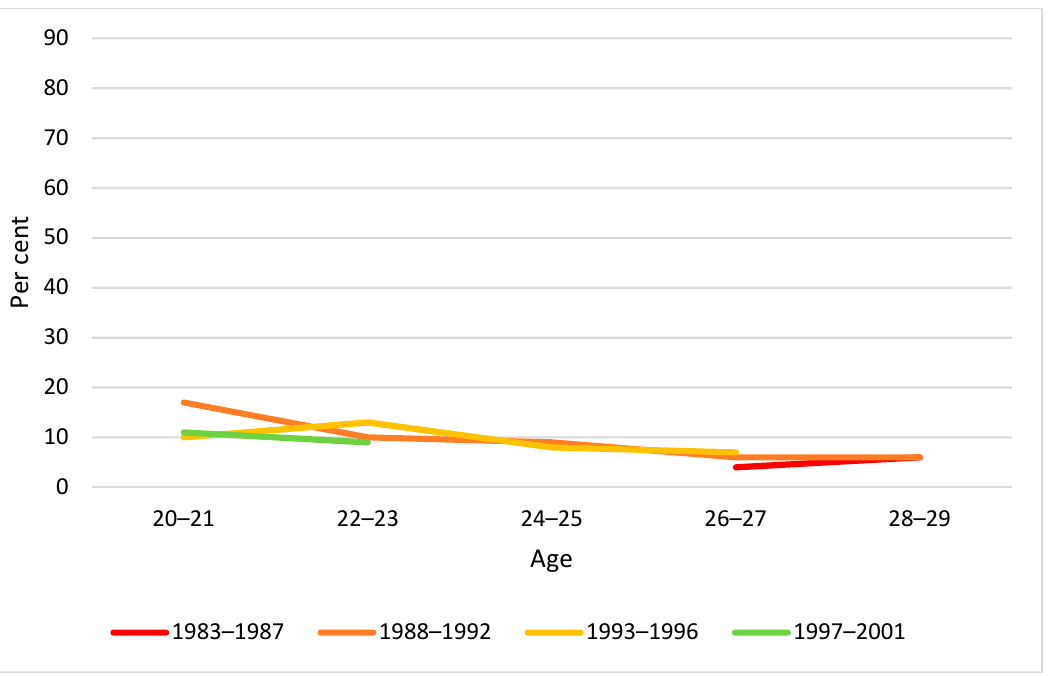
Figure 7. Proportion weekly HED by birth cohort and age. Note: None of the cohort differences at any age were statistically significant ( p > 0.05).